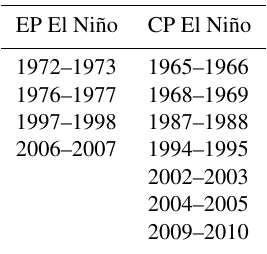
Table 2. Eastern Pacific (EP) and central Pacific (CP) El Niño events used in this study, as identified by a majority consensus of three